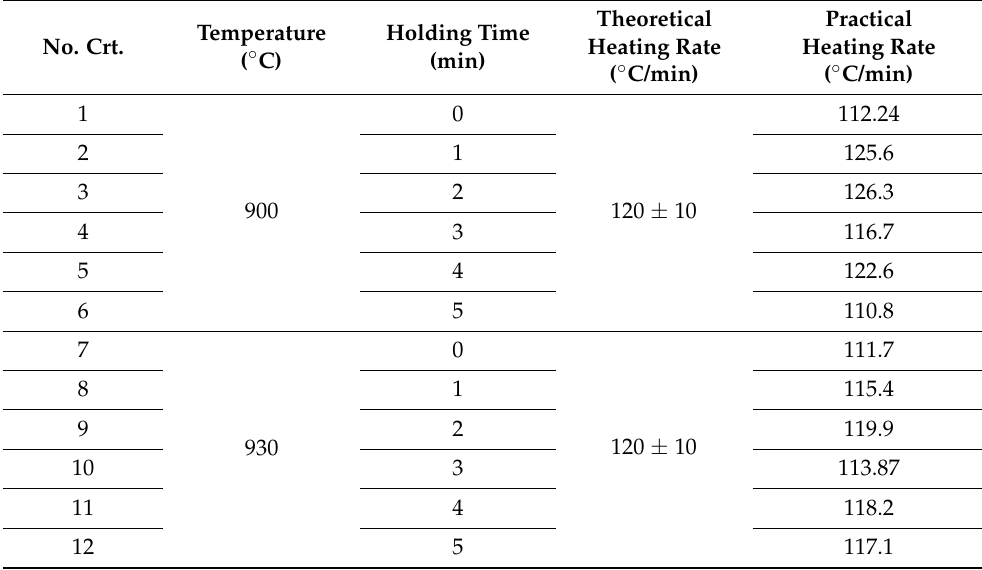
Table 1. The sintering parameters.